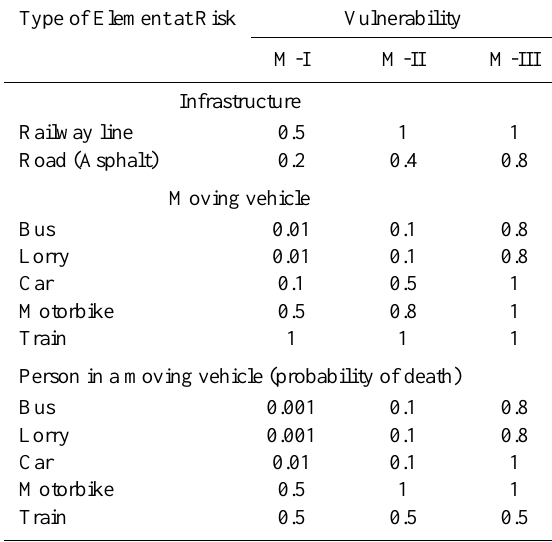
Table 4. Estimated vulnerability for elements at risk affected by a